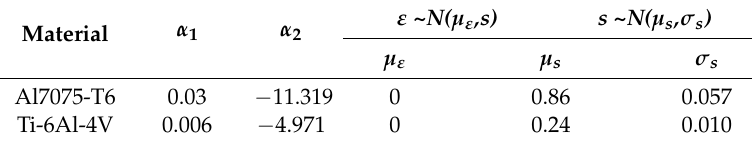
Figure 6. Estimated error terms.